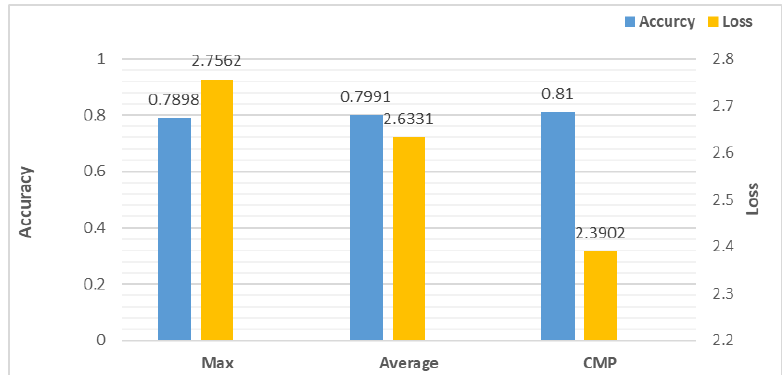
Figure 10. Pooling performance result using crawling data.